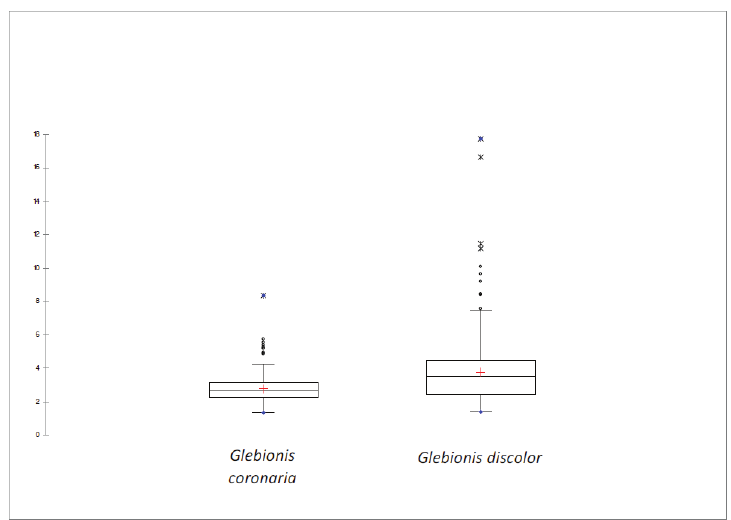
Figure 5. Statistical analysis by box plot of ratio cypsela-wing width of Glebionis coronaria and G. discolor .